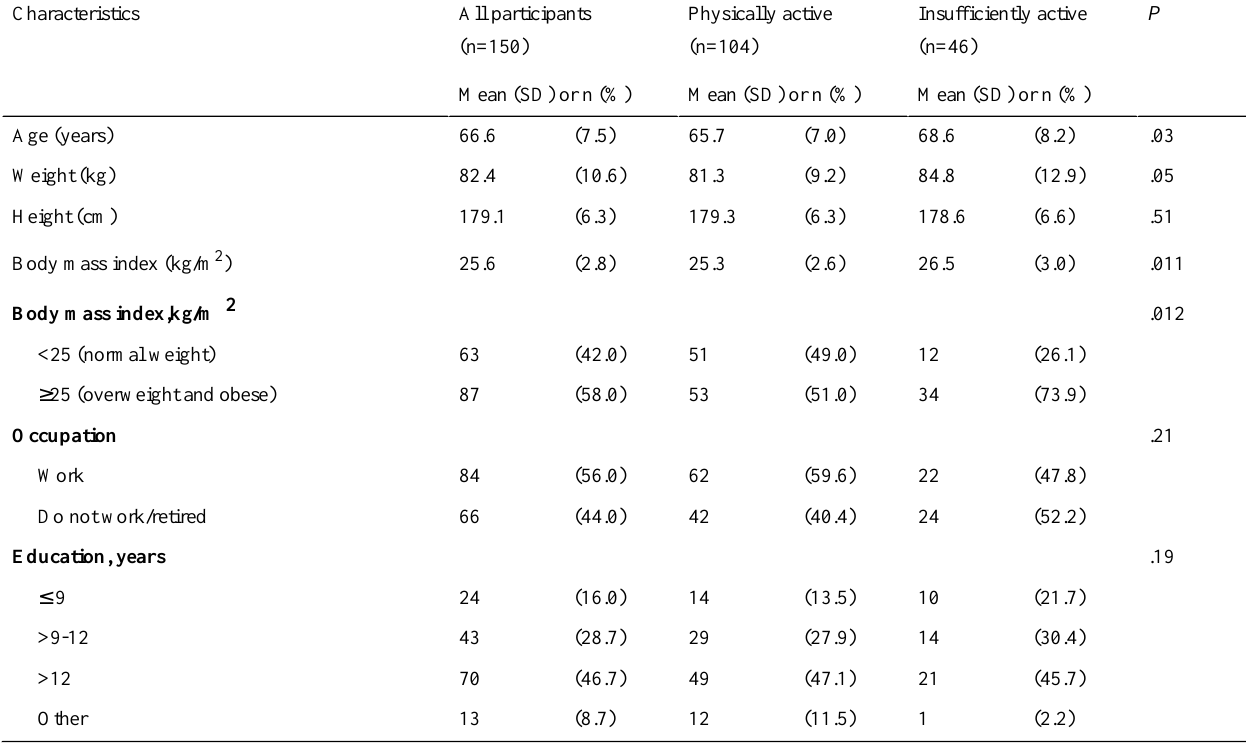
Table 1. Characteristics of the study